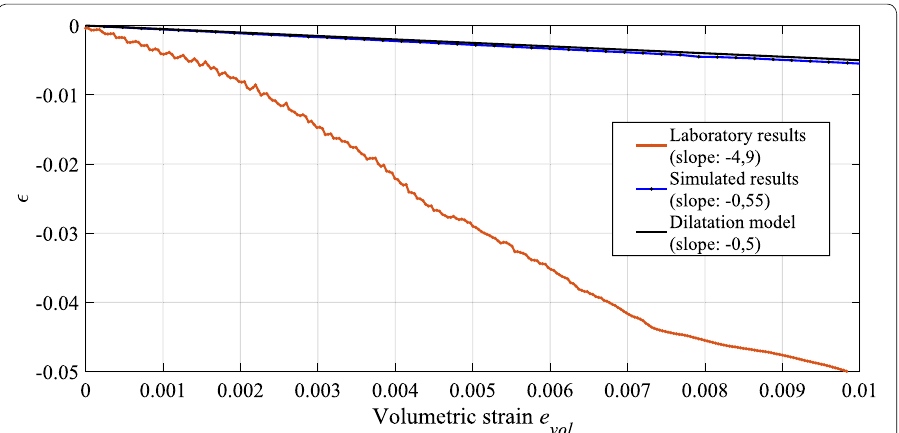
Fig. 11 Comparison of simulated and laboratory CWI measurements with the time dilatation model. We represent the CWI measurements obtained at the laboratory (orange line) during second heating cycles of Westerly Granite and simulated results (blue line) with volumetric strain. We compare the measurements to those expected from the time dilatation model (black line). A linear regression is fitted the measurements to estimate the